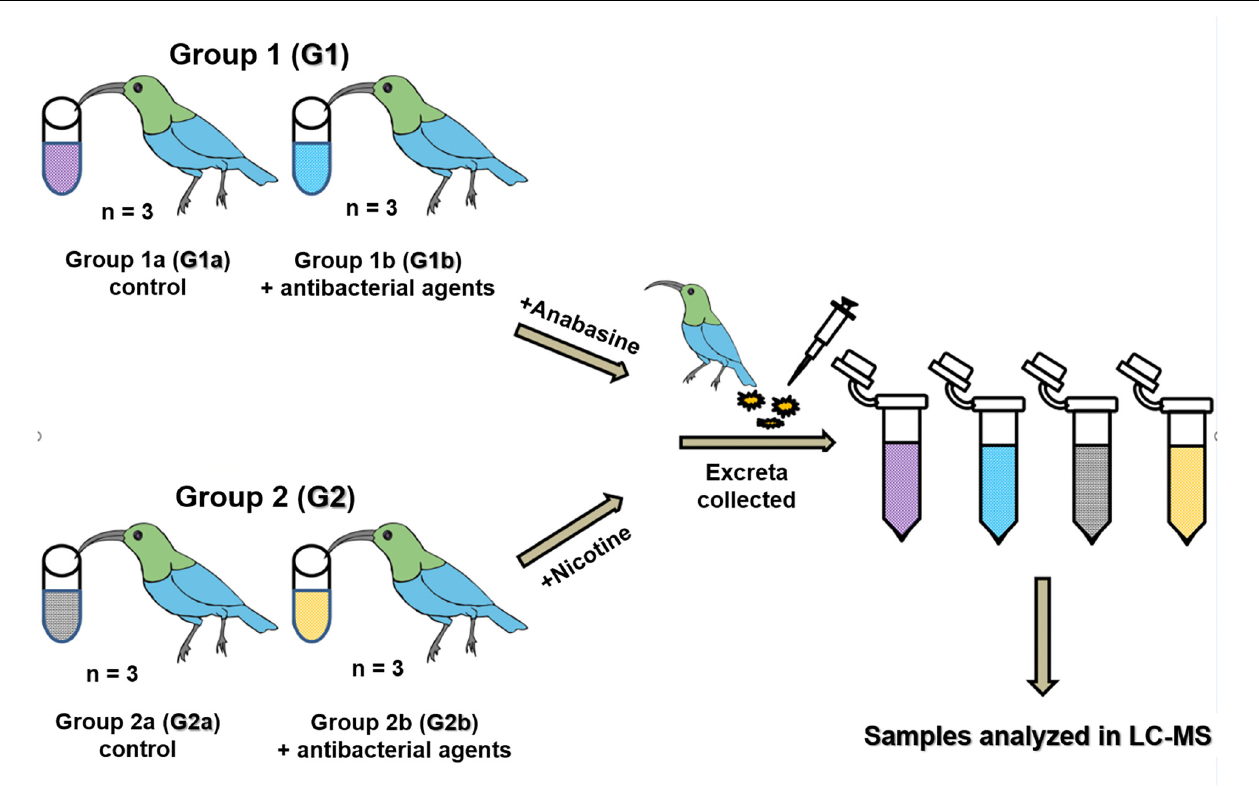
FIGURE 1 | Dysbiosis experiment. Sunbirds were divided into two groups (G1 and G2) which were further divided into two sub-groups a and b. All birds were fed with artificial nectar. A mixture of sulfamethoxazole and trimethoprim was mixed with the artificial nectar to a final concentration of 8 and 1.6 mg/ml, respectively, and fed to the birds in groups G1b and G2b for 72 h. Then, anabasine was added to all the birds in group G1 and nicotine was added to all the birds in group G2. The addition of the antibacterial agents to the food of subgroups G1b and G2b continued in parallel to the addition of the pyridine alkaloids, until the end of the experiment. Excreta samples were collected for anabasine and nicotine degradation analysis in the LC-MS after 24 and 72